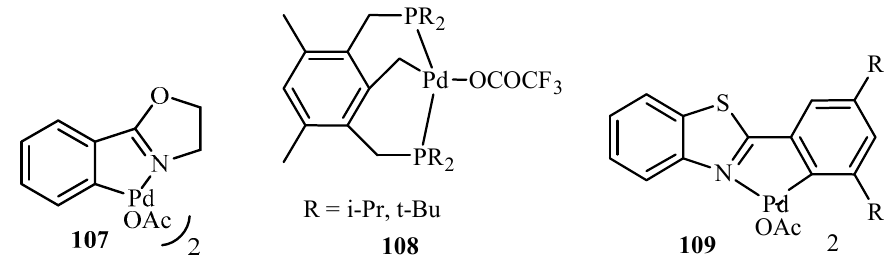
Figure 11. Palladacycles and coordinatively unsaturated Pd catalysts featuring bulky phosphanes of high denticity in review by Farina [23].